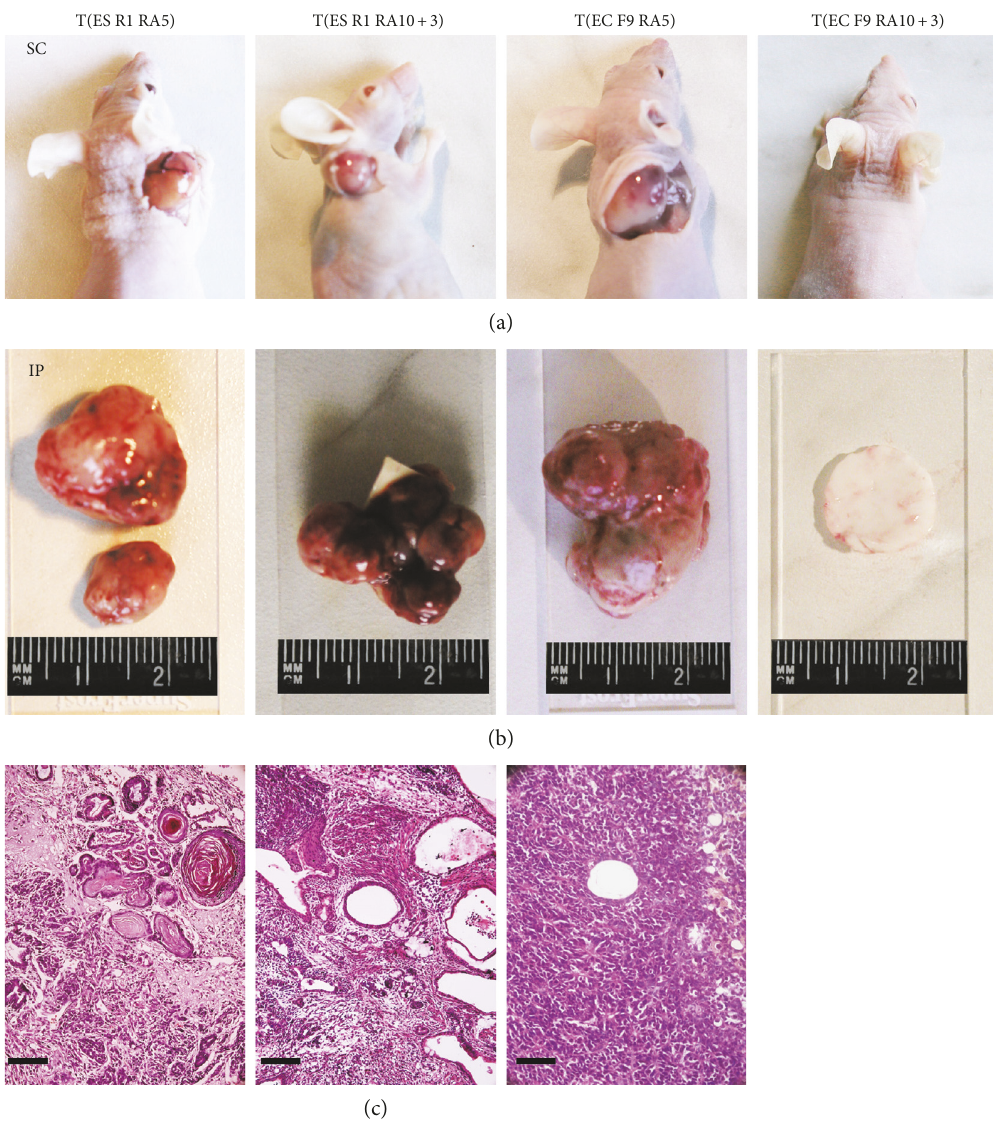
Figure 4: Tumorigenic and di ff erentiation potential of RA-simulated ES R1 and EC F9 cells after transplantation into nude mice. (a and b) teratomas and teratocarcinomas developed in nude mice after subcutaneous (SC) and intraperitoneal (IP) transplantation of ES R1 and EC F9 cells on day 5 RA stimulation (T(ES R1 RA5), T(EC F9 RA5)) and on day 3 after RA withdrawal (T(ES R1 RA10+ 3), T(EC F9 RA10+3)). (c) Sections through teratomas and teratocarcinomas formed by RA-simulated ES R1 and EC F9 cells after transplantation into nude mice. The teratomas contain derivatives of three germ layers while the teratocarcinomas consisted entirely of undi ff erentiated cancer cells. No teratocarcinomas have formed during 30 weeks after the transplantation of EC F9 cells on day 3 after RA withdrawal (RA10 +3). Scale bar =100 μ